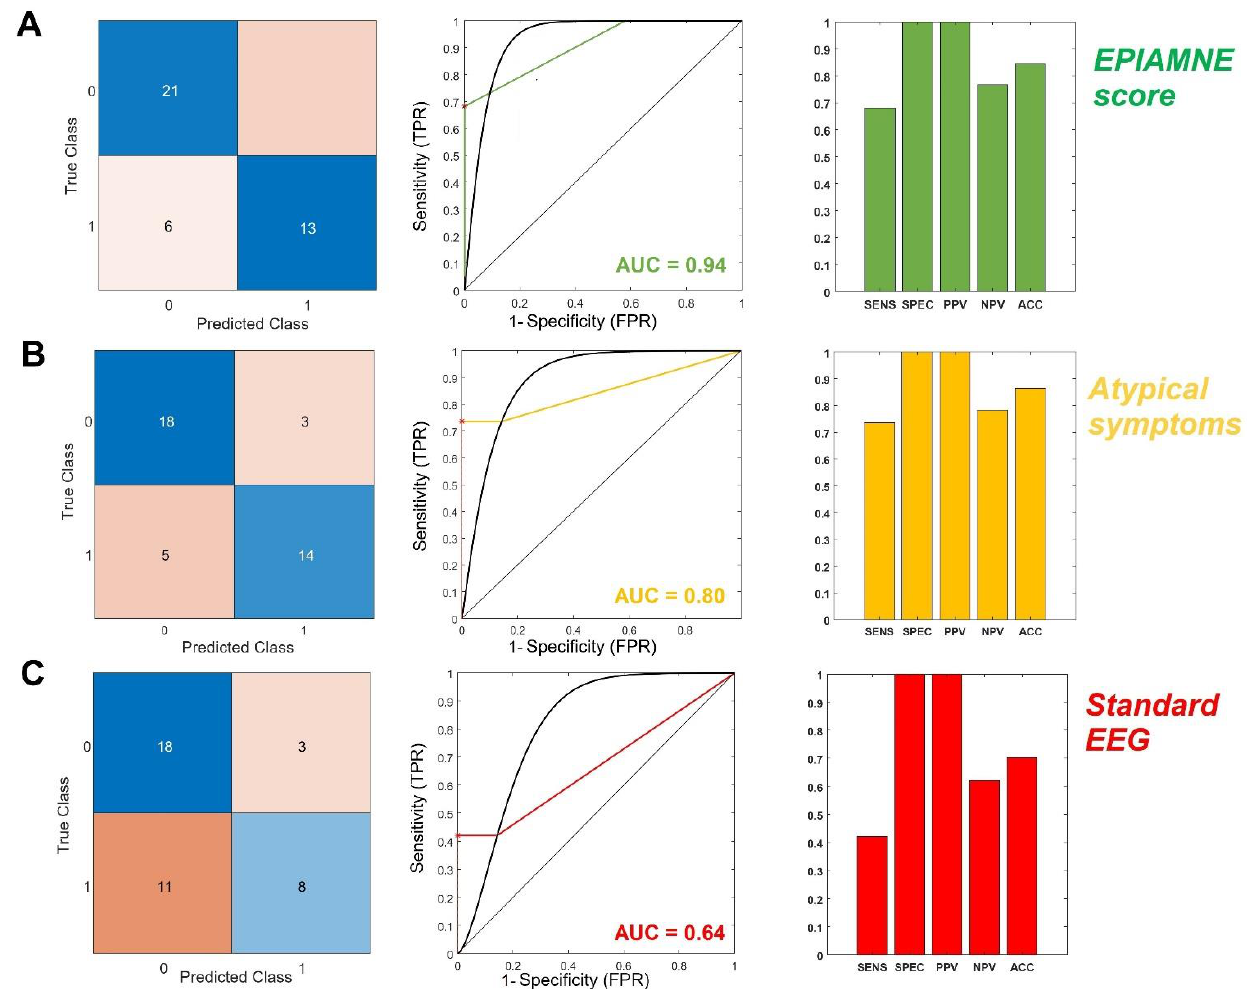
Figure 5. ROC curve comparison of the EPIAMNE score ( A ), pSymAT (atypical symptoms) ( B ) and standard EEG ( C ). ACC (accuracy), AUC (Area Under the Curve), EPIAMNE score (EPIlepsy AMNEsia Score), FPR (false positive rate), NPV (Negative Predictive Value), PPV (Positive Predictive Value), SENS (sensitivity), SPEC (specificity), TPR (true positive rate). Diagnostic parameters of EPIMANE score are displayed in Figure